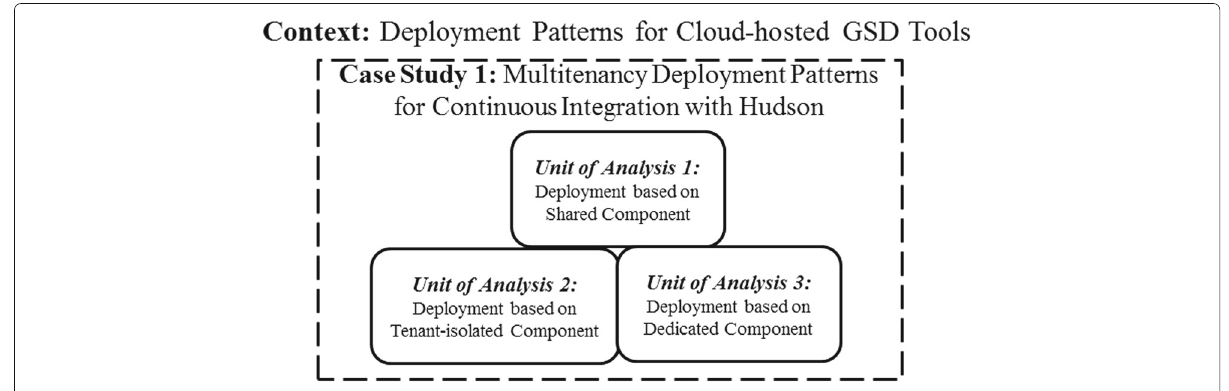
Fig. 3 Multiple-case (embedded) design adopted for the study